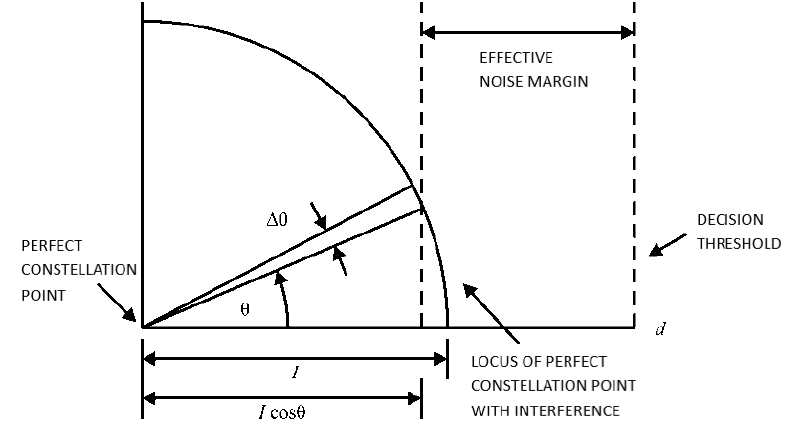
Figure 4. Symbol error mechanism due to noise and narrow-band radio interference.